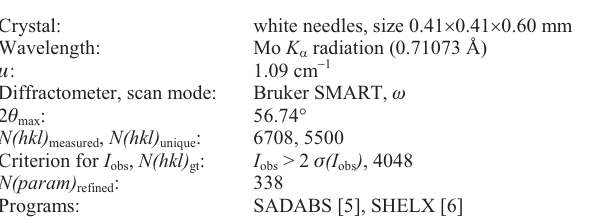
Table 1. Data collection and handling.